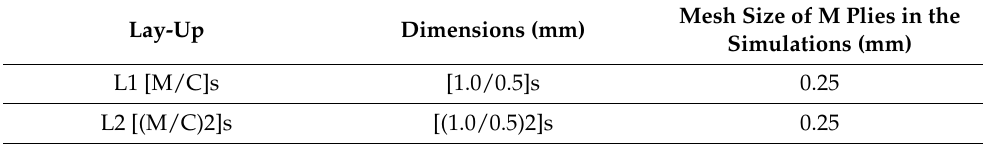
Figure 1. Lay-up designs. ( a ) L1 and ( b ) L2.